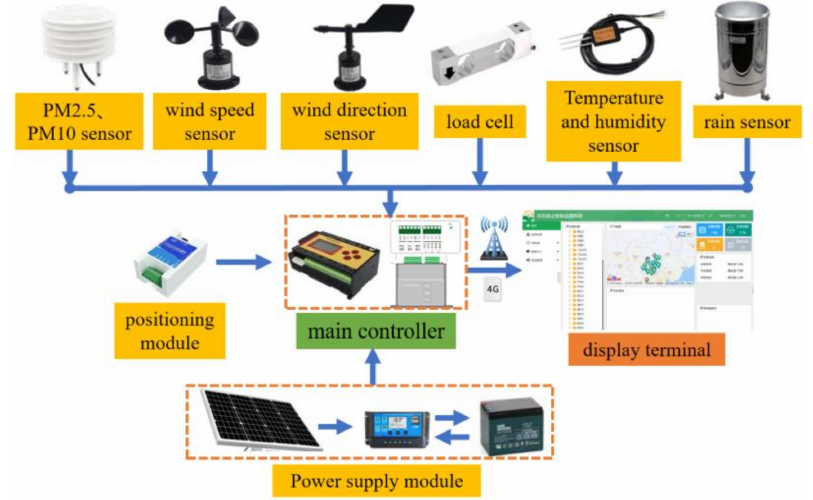
Figure 5. Farmland dust online monitoring